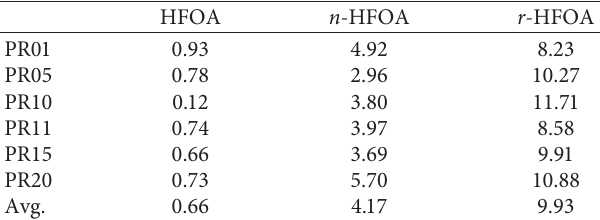
Table 2: Comparisons of the RPI values for different initialization methods. HFOA n -HFOA